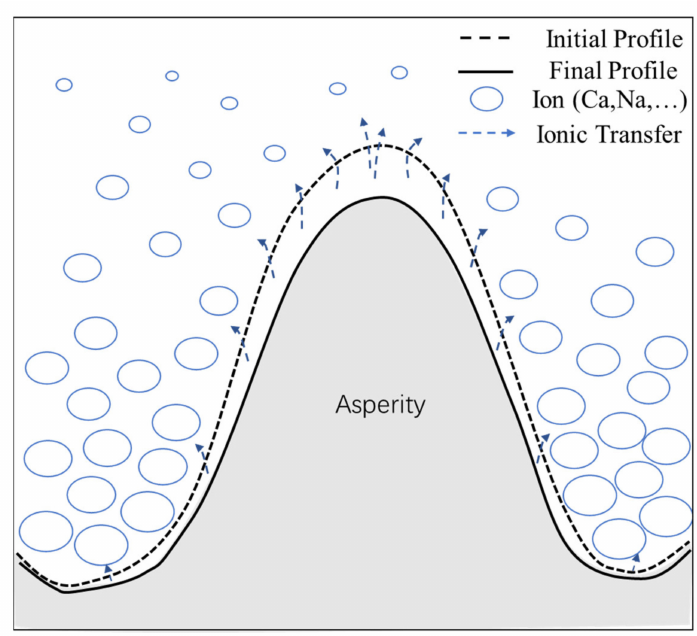
Figure 20. Illustration of concrete rough fracture leaching model. In Figure 20, the dashed line is the initial profile; the solid line is the final profile after the leaching experiment; the blue circles represent ions or ion clusters (mainly calcium); the size and density indicate ion mass and concentration; the dashed line with arrows indicates the direction of ion transport; and the length of the dashed line indicates the